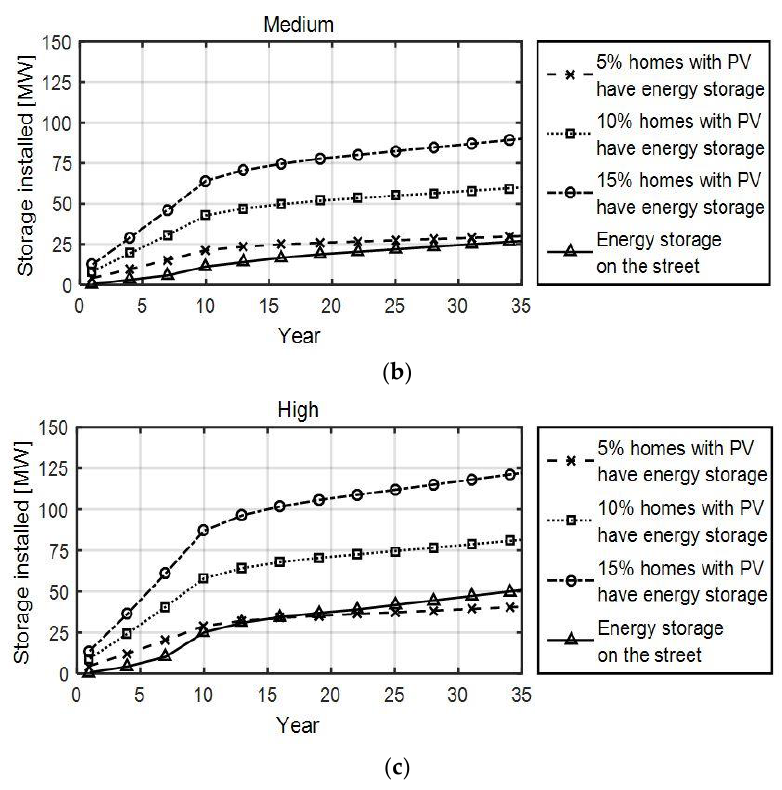
Figure 8. The capacity of storage installed both with storage randomly located in homes, and DNO installed storage, for ( a ) low; ( b ) medium; and ( c ) high PV penetrations.